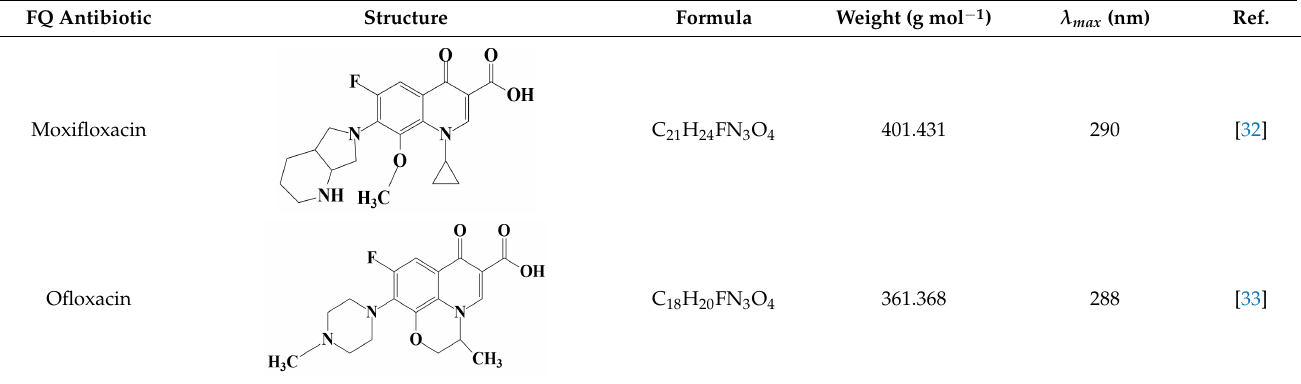
Table 1. Chemical structure and physicochemical properties of FQs antibiotics. FQ Antibiotic